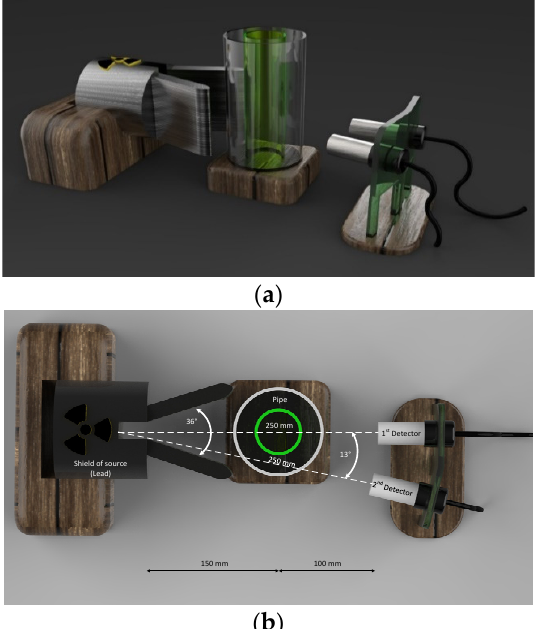
Figure 2. The structure of a simulated setup using MCNP: ( a ) 3D view, ( b ) View from above.